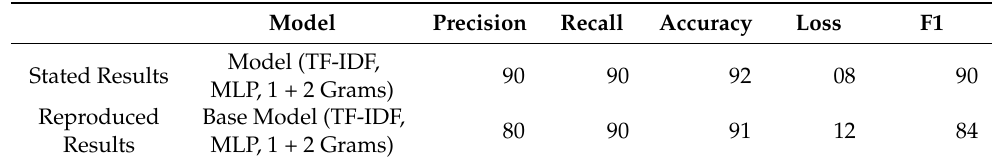
Table 2. Evaluation Table of State of the Art Model (Sadiq, S (2021) Model [15]) (Stated vs. Reproduced